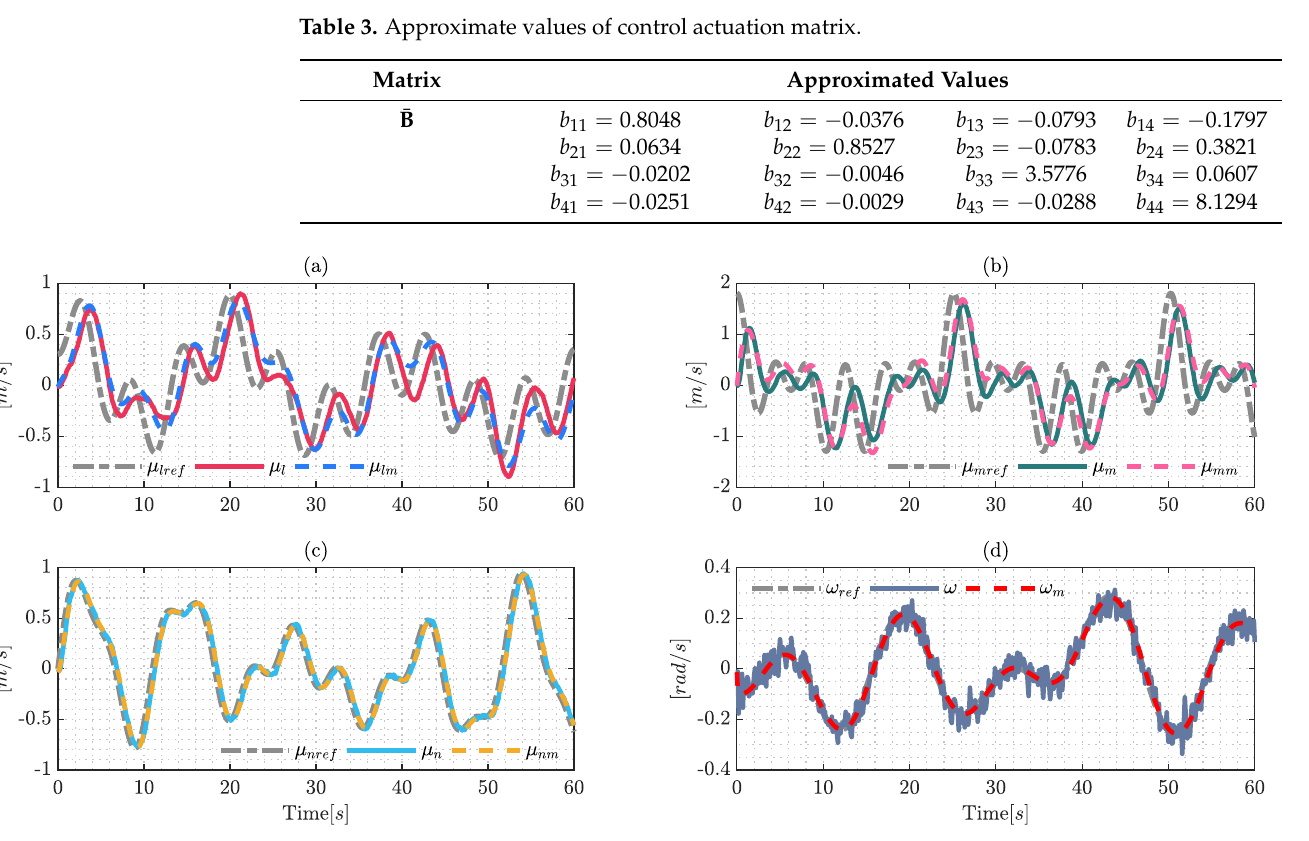
Figure 4. Identification process using dynamic mode decomposition formulation (DMD): ( a ) results over µ lref ; ( b ) identification on µ mref ; ( c ) validation over µ nref ; and ( d ) shows the results on ω ref